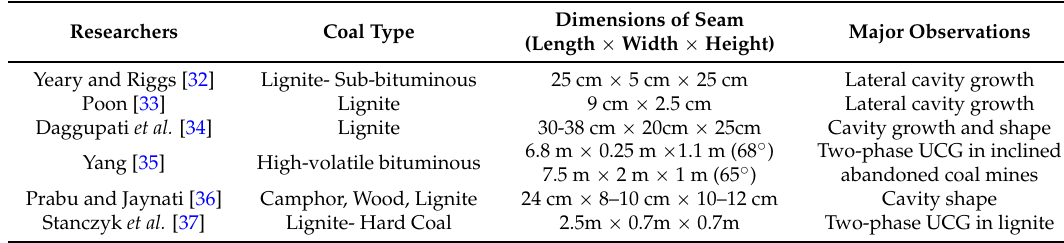
Table 3. Major UCG experiments on coal blocks